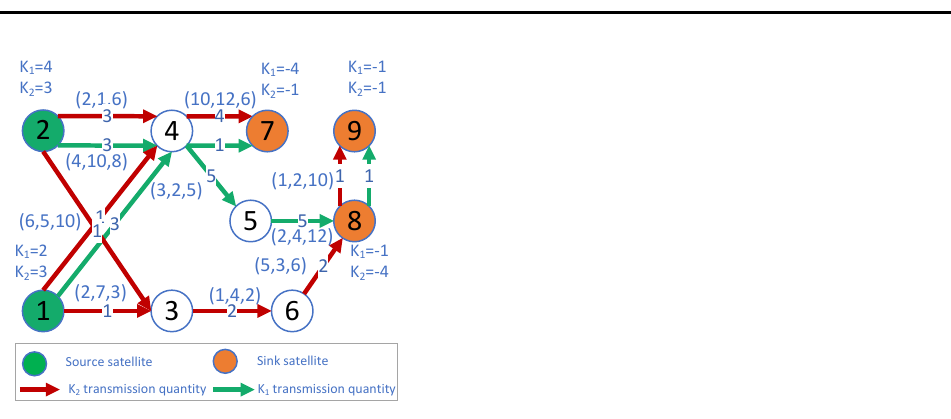
Figure 6. Satellite resource request queue reconstruction and inter-satellite resource